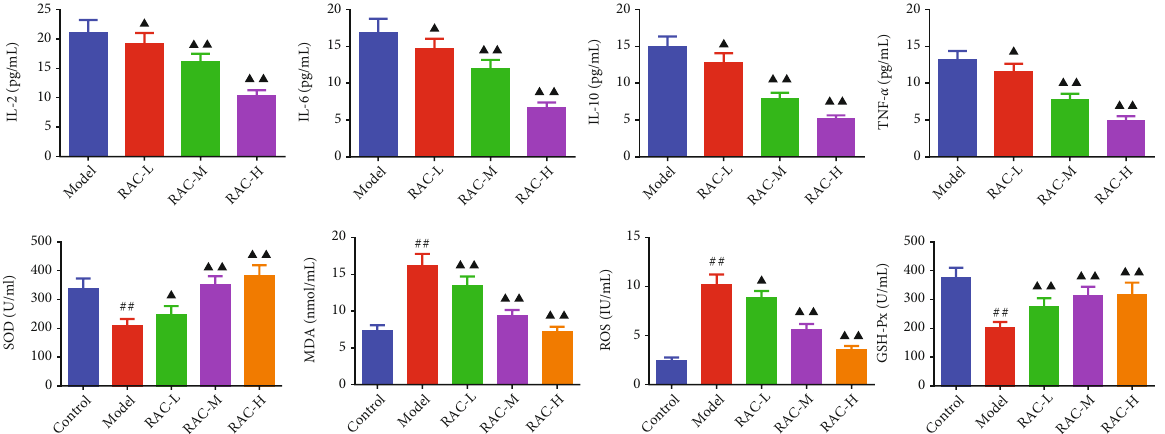
Figure 5: RAC diminished the release of in fl ammatory cytokines and oxidative stress factors in RCC mice. The contents of tumor IL-2, IL-6, IL-10, and TNF- α and serum SOD, MDA, ROS, and GSH-Px in the tumor tissue or serum were measured by ELISA. ▲ P < 0 : 05 and ▲▲ P < 0 : 01 vs. the model. # P < 0 : 05 and ## P < 0 : 01 vs. the control. Results were presented as mean ± SD . n = 6 . Note: RAC: Radix Actinidia chinensis; RCC: renal cell carcinoma; ELISA: enzyme-linked immunosorbent assay.